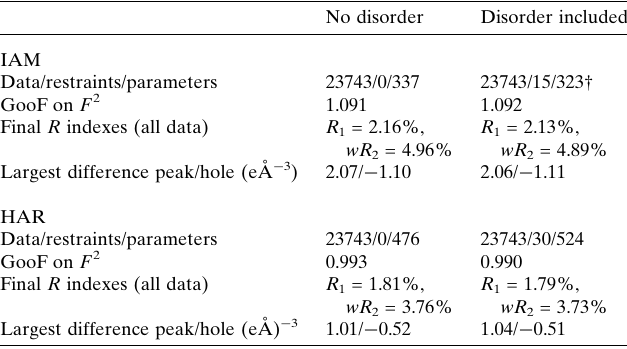
Table 2 Comparison of agreement statistics for IAM and HAR models. The HAR models presented here are obtained at the DFT/PBE level of theory with the DKH2 Hamiltonian and with hydrogen ADP values resulting from HAR